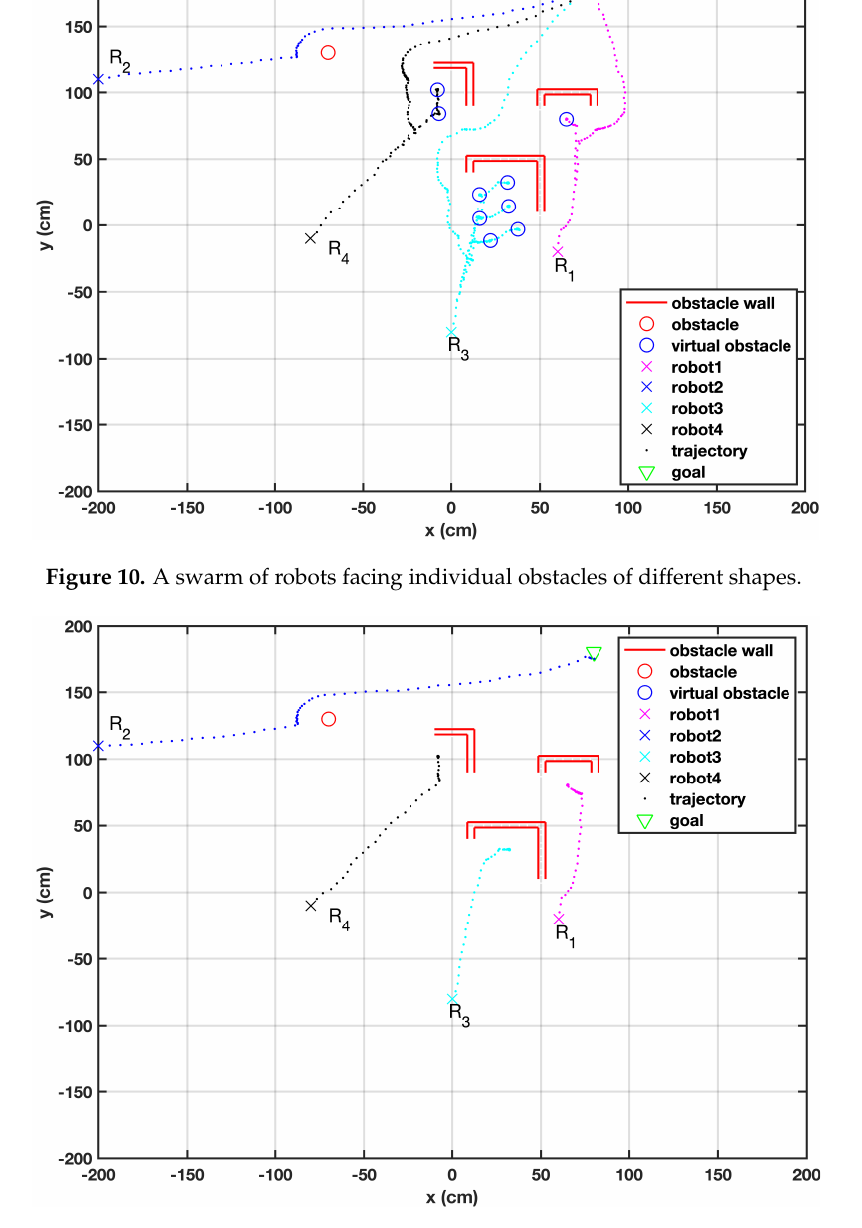
Figure 11. A swarm of robots facing individual obstacles